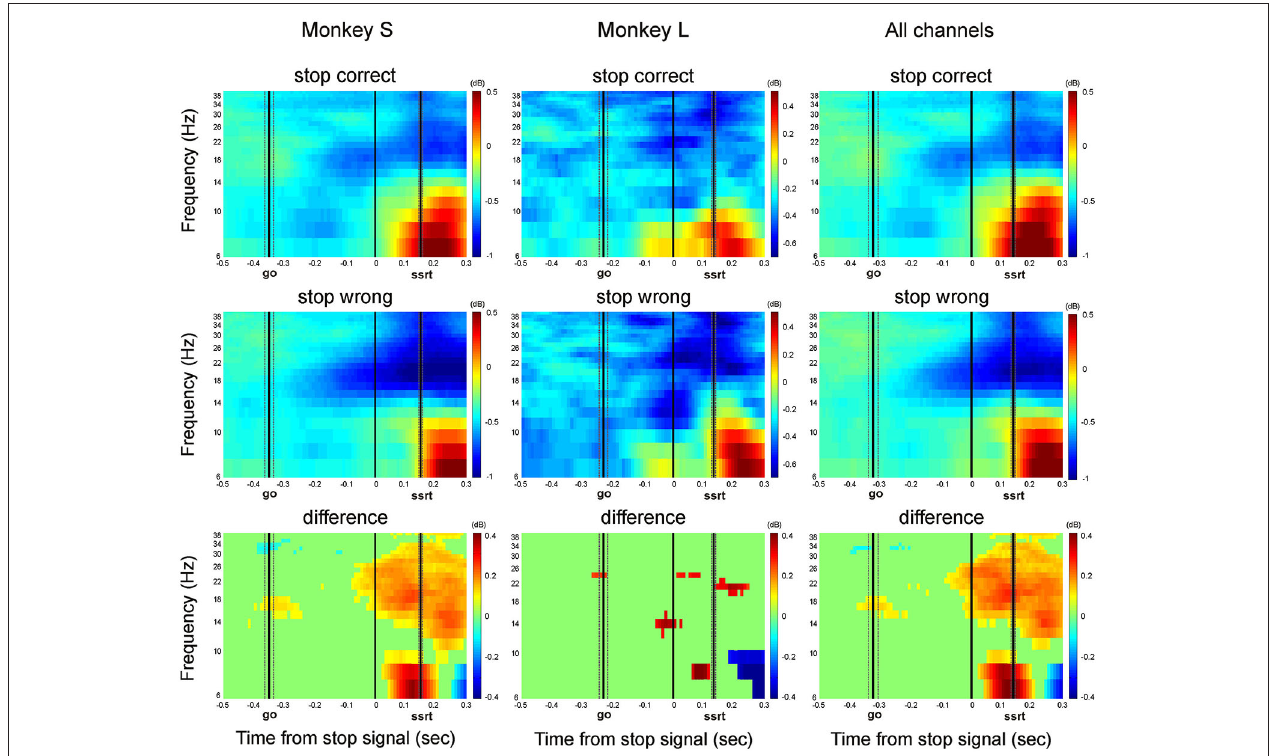
FIGURE 5 | Comparison between correct stop and wrong stop, aligned to stop signal presentation . Conventions are as in Figure 4 .